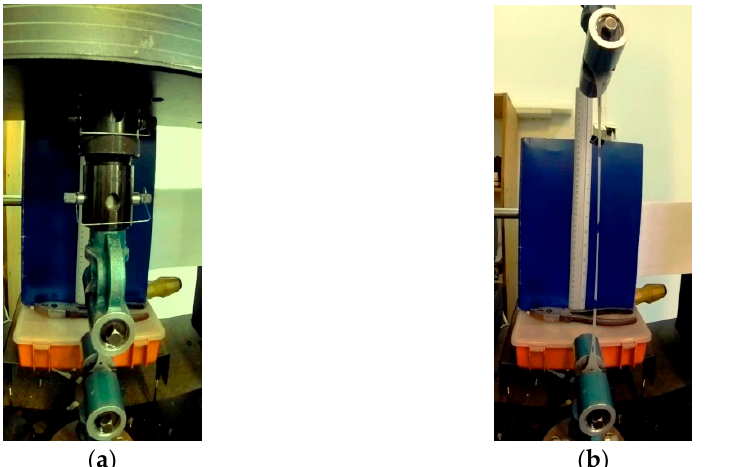
Figure 1. A polyurea specimen in the tensile tester: ( a ) At the beginning of the tension test; ( b ) be- fore breaking.